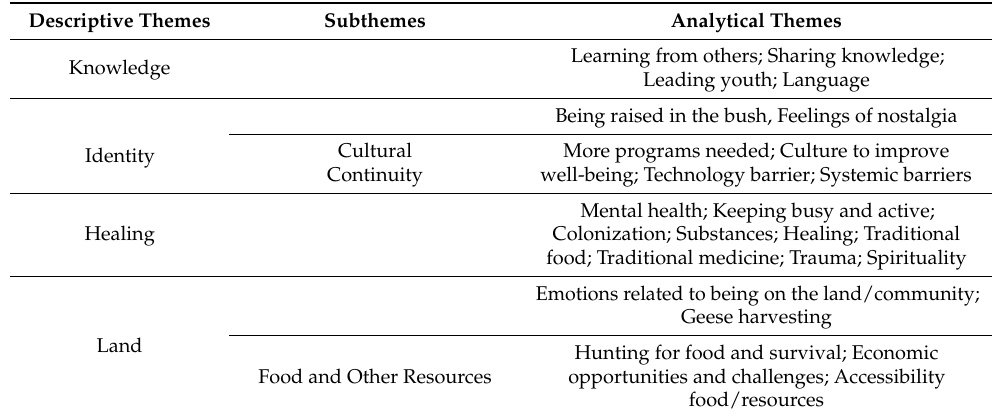
Table 2. A summary of the thematic